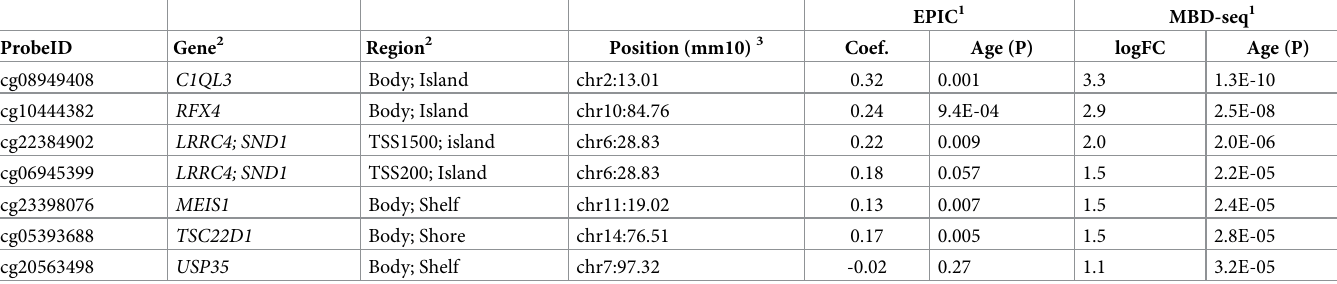
Table 4. Age-dependent differentially methylated CpGs/regions detected by conserved Illumina human MethylationEPIC probes and by